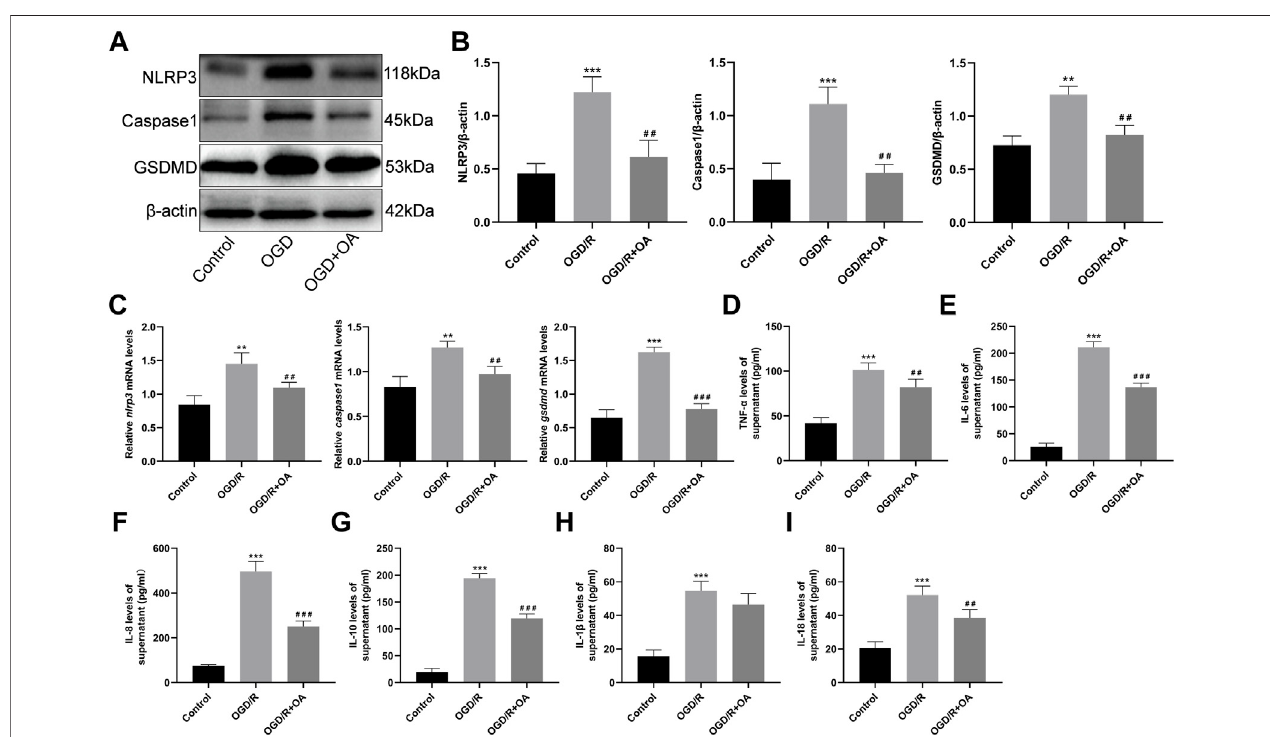
FIGURE 4 | OA treatment attenuates OGD/R induced pyroptosis and in fl ammation (A,B) WB and quantitative analysis for NLRP3, Caspase1, and GSDMD expression levels intheheart tissues (C) RT-qPCRdatashowing thetranscriptslevels for nlrp3, caspase1, and gsdmd intheheart tissues (D – I) ELISAresultsshow that thelevelsofTNF- α ,IL-6,IL-8,IL-10,IL-1 β andIL-18inthesupernatantineachgroup.Dataarepresentedasthemean±SD. pp p < 0.01and ppp p < 0.001,comparedwith the Control group; ## p < 0.01 and ### p < 0.001, compared with the OGD/R group. OGD/R: oxygen-glucose deprivation/reperfusion; OA: Oroxin A; WB: Western Blot; RT-qPCR reverse-transcription quantitative PCR; ELISA: enzyme-linked immunosorbent